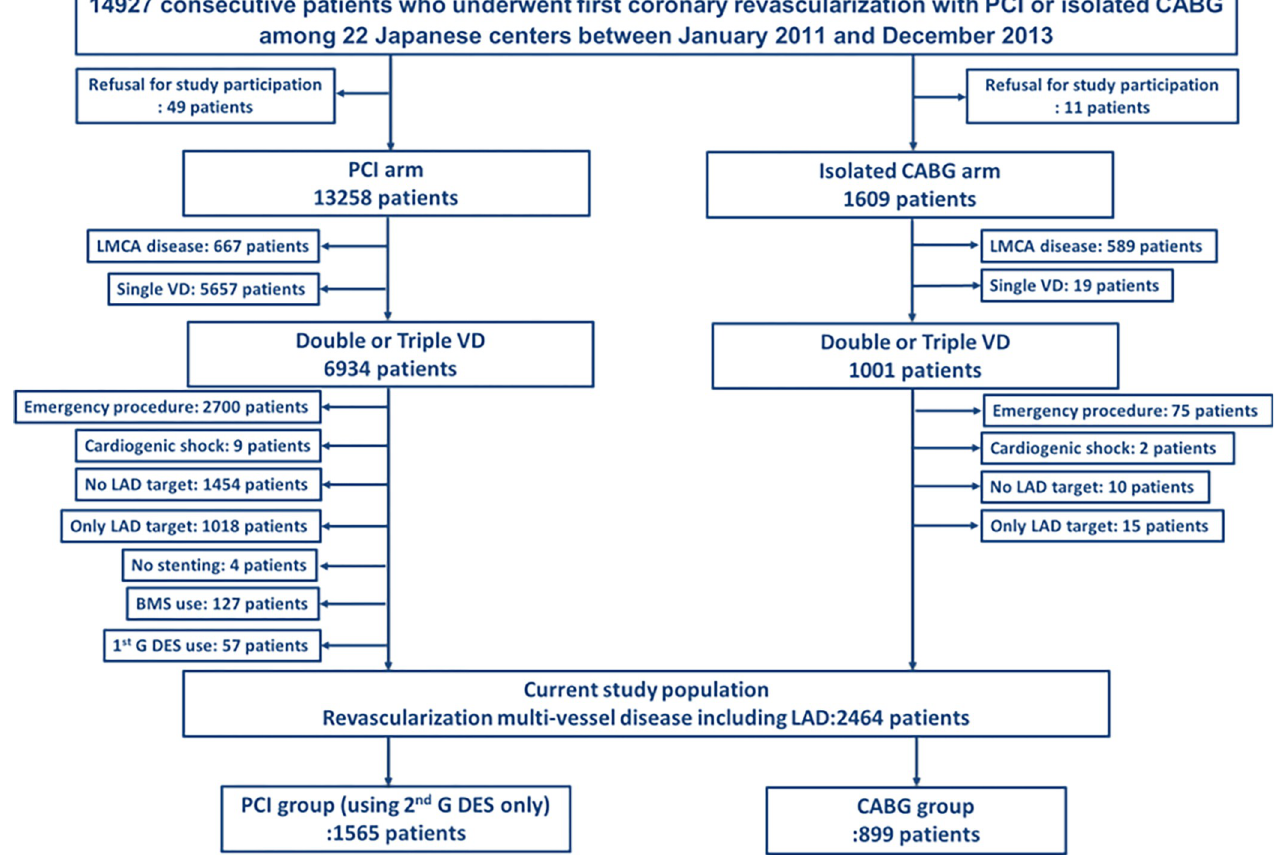
Fig 1. Study flowchart. BMS = bare-metal stent; CREDO-Kyoto PCI/CABG Registry Cohort-3 = Coronary Revascularization Demonstrating Outcome Study in Kyoto PCI/CABG registry; CABG = coronary artery bypass grafting; G-1 DES = first-generation drug-eluting stent; LAD = left anterior descending coronary artery; LMCA = left main coronary artery; PCI = percutaneous coronary intervention; G-2 DES = second-generation drug-eluting stent.